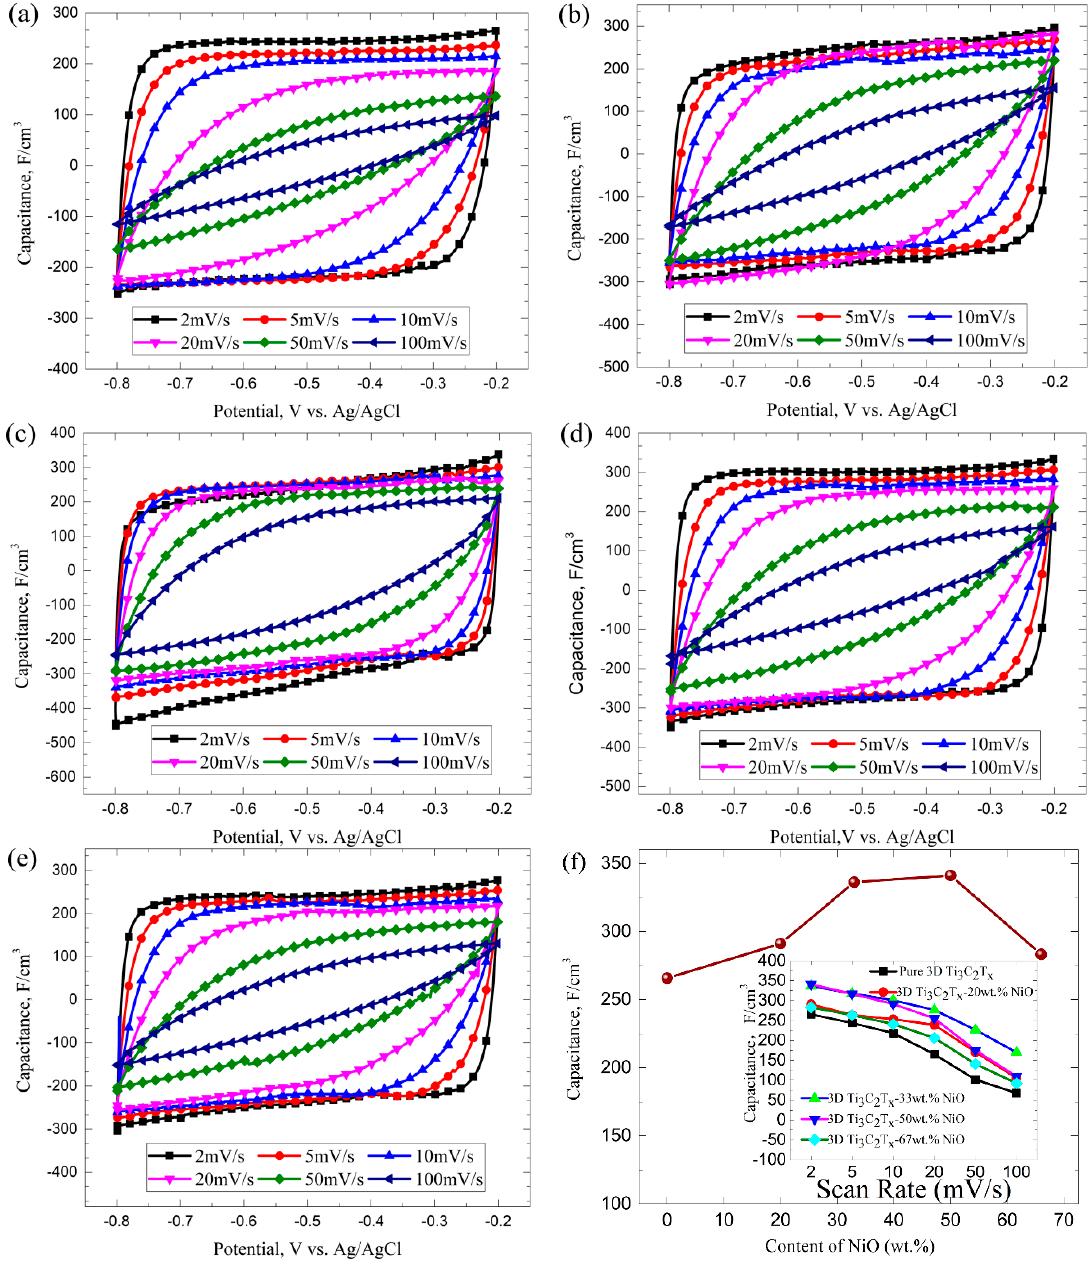
Figure 3. Electrochemical performance of 3D porous Ti 3 C 2 T x and Ti 3 C 2 T x -NiO composites. Cyclic voltammetry data collected at scan rates from 2 to 100 mV/s for ( a ) pure 3D porous Ti 3 C 2 T x , ( b ) 3D porous Ti 3 C 2 T x -20 wt. % NiO, ( c ) 3D porous Ti 3 C 2 T x -33 wt. % NiO, ( d ) 3D porous Ti 3 C 2 T x -50 wt. % NiO, and ( e ) 3D porous Ti 3 C 2 T x -66 wt. % NiO. ( f ) The NiO content and scan rate dependence of specific capacitance.